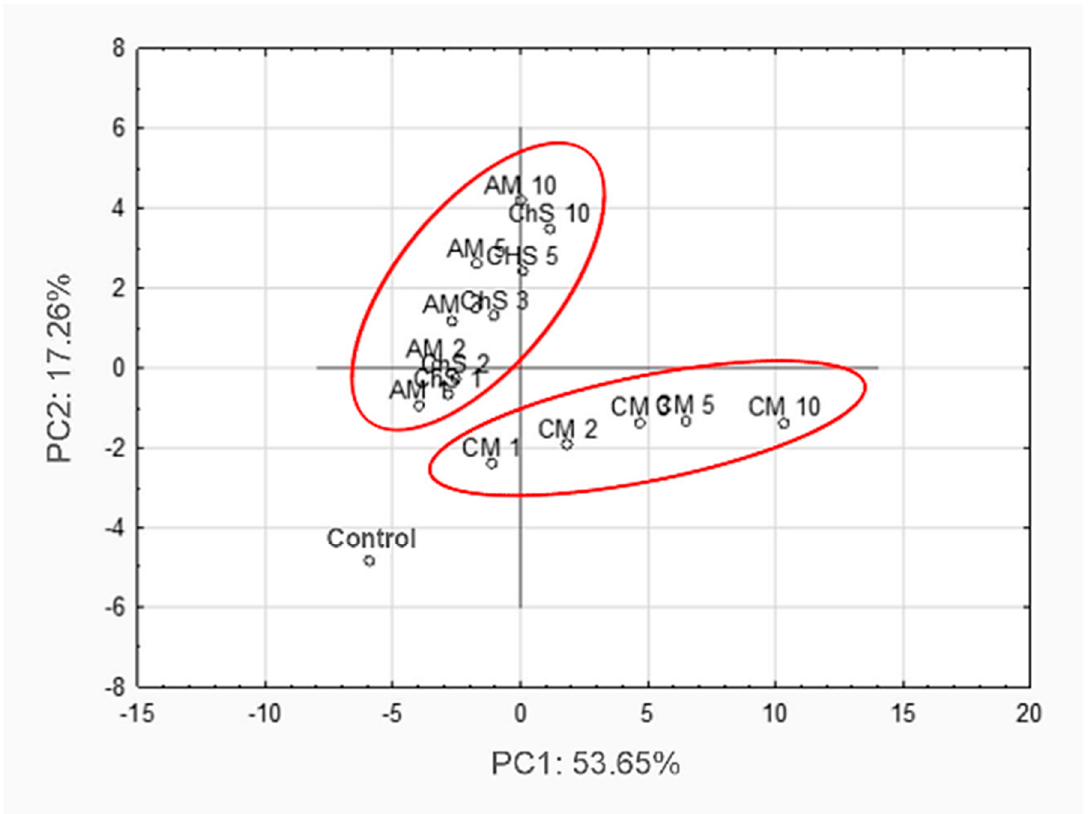
Figure 2. Principal component analysis (PCA) presenting the effect of leaf extracts on the growth of meat spoilage and pathogenic bacteria. (AM- Aronia melanocarpa , CM – Cornus mas , ChS – Chaenomeles superba ; 1,2,3,5,10 – concentrations of extract [%]).